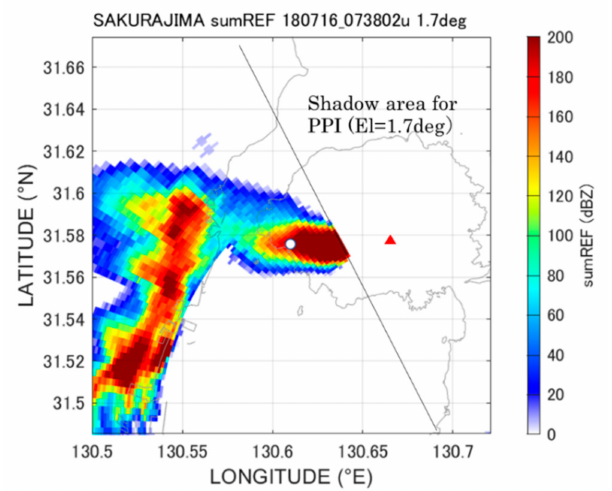
Figure 6. Plan position indicator (PPI) image of time-integrated radar reflectivity for eruption clouds formed in eruption 6 (16 July 2018). PPI images were obtained every 2 min at an elevation angle of 1.7 ◦ . Circle indicates the location of Parsivel 2 ; triangle indicates the summit of